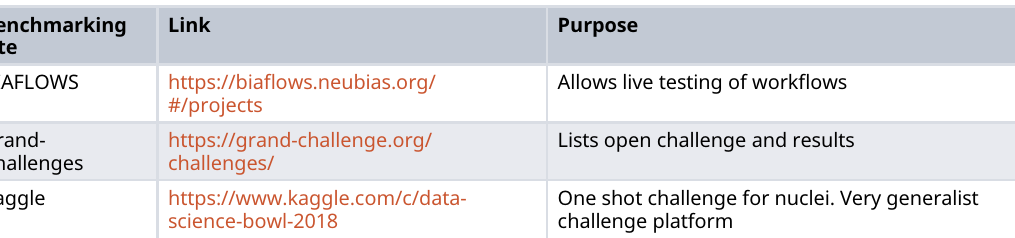
Table 2. Example of websites to compare existing workflows on reference